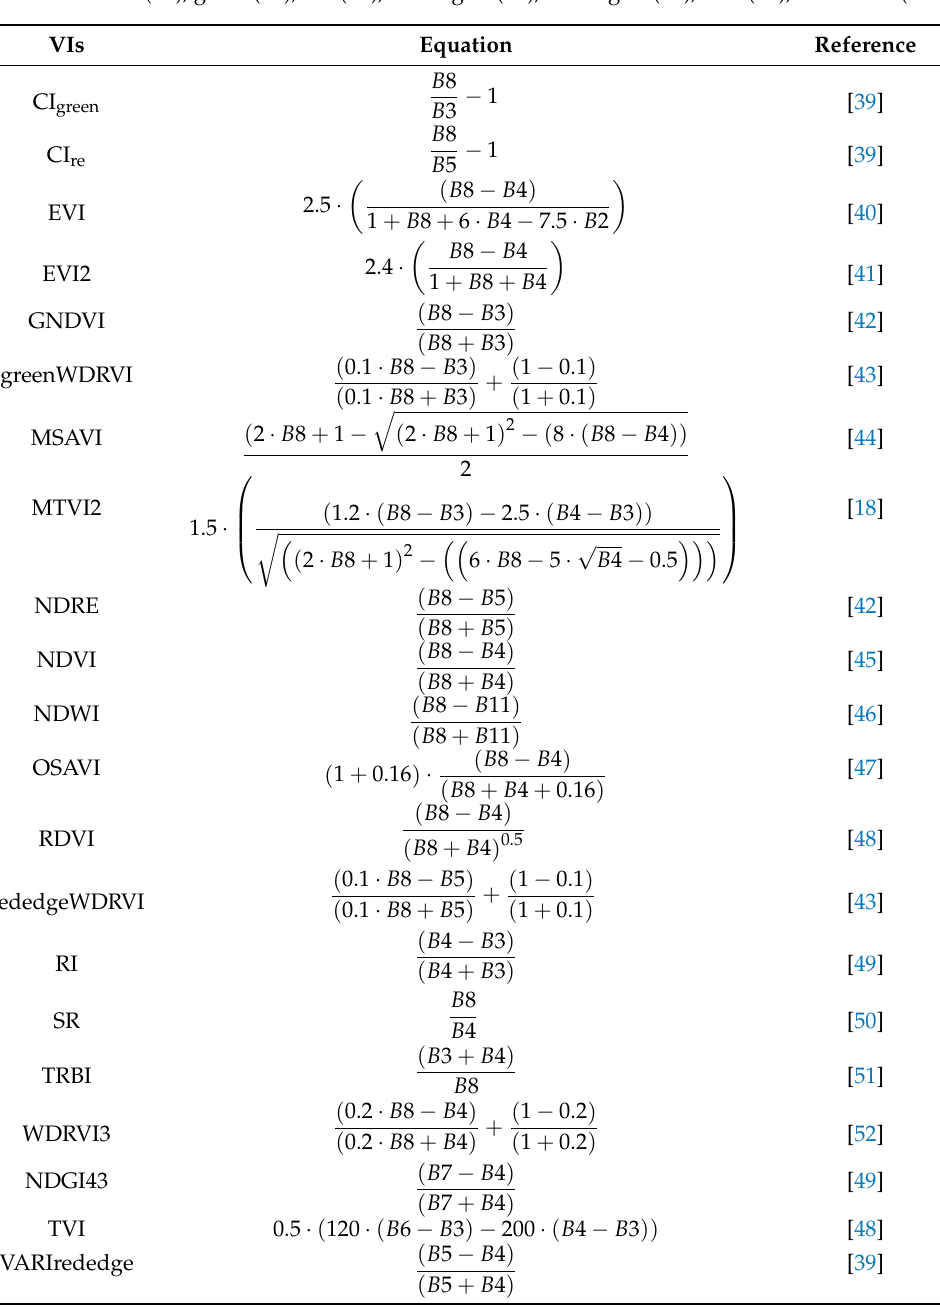
Table 2. List of the vegetation indices evaluated for the retrieval of Leaf Area Index. Sentinel-2 bands used are the blue (B2), green (B3), red (B4), red-edge 1 (B5), red-edge 3 (B7), NIR (B8), and SWIR